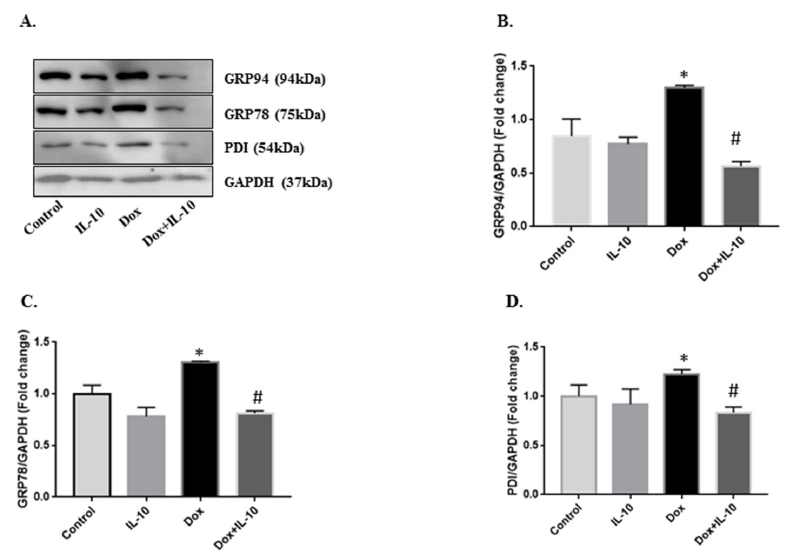
Figure 2. IL-10 effects on Dox-induced changes in ER stress markers. Expression of the unfolded protein response (UPR) chaperones in isolated cardiomyocytes treated with doxorubicin (Dox, 5.43 µg/mL) in the presence or absence of interleukin-10 (IL-10, 10 ng/mL) for 24 h. ( A ) Western blot of respective proteins using KDEL antibody (1:1000), which recognizes GRP94, GRP78, and PDI. Densitometric analysis of respective proteins ( B ) GRP94; ( C ) GRP78; and ( D ) PDI. GAPDH was used as the loading control. Data are means +/ − SE from 5 individual experiments. * p < 0.001 vs. control, IL-10; # p < 0.001 vs. Dox.